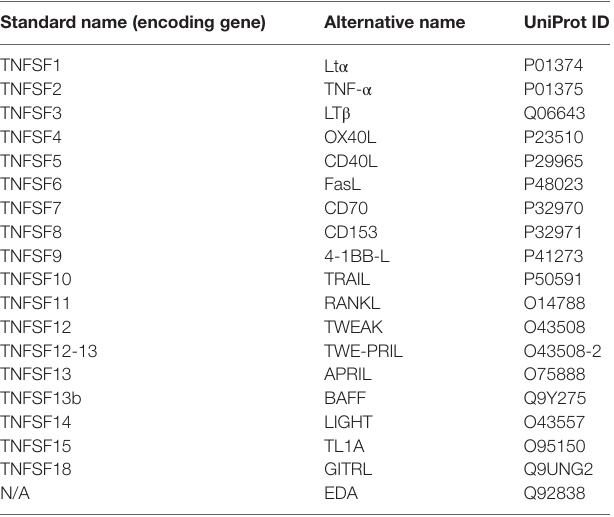
TaBle 1 | Relation of TNF superfamily ligands (TNFSF) present in human indicating their standard name within the TNF superfamily and their alternative (most common)